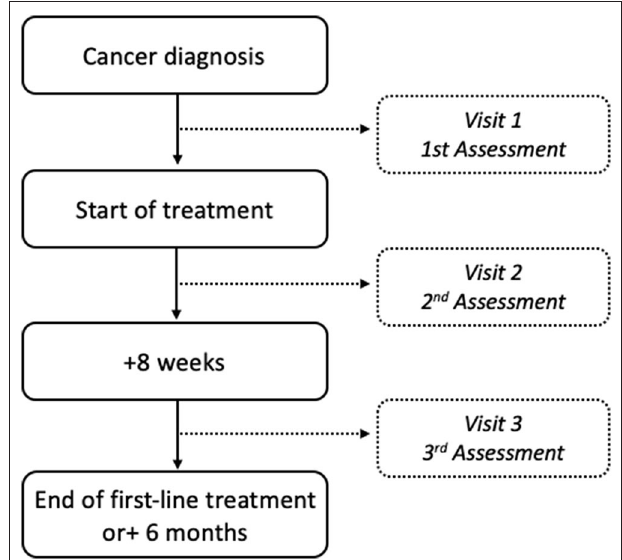
TABLE 1 | Inclusion and exclusion criteria.